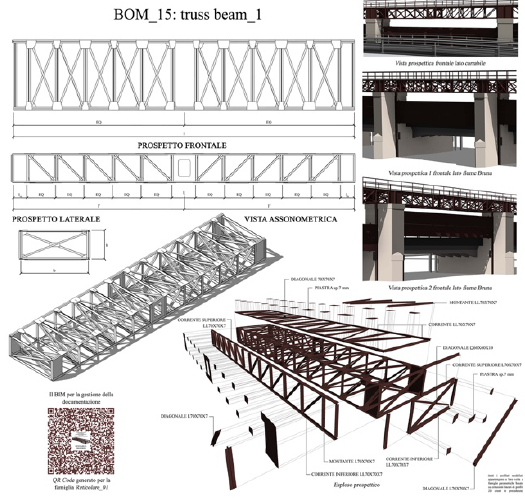
Figure 7. Sample of Historical BOM: truss beam_15